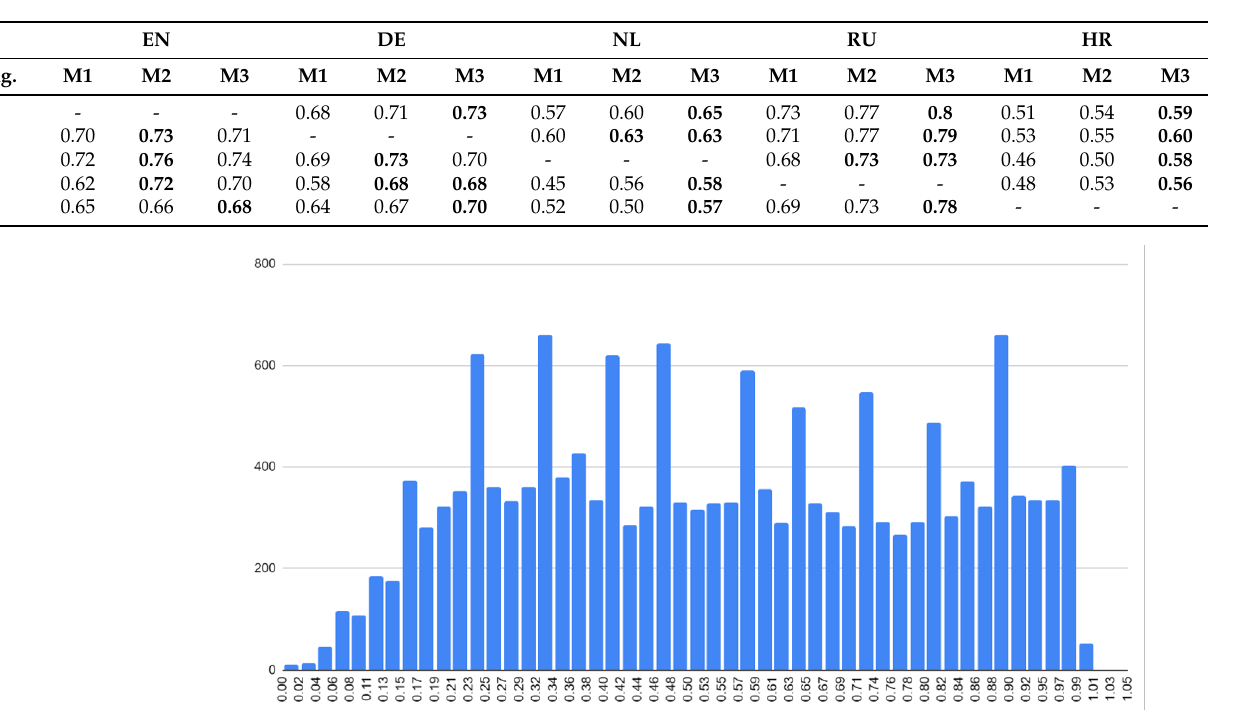
Table 3. Spearman’s correlation coefficient for complete dictionaries. Notation: ‘M1’ stands for the distilled multilingual BERT, ‘M2’ stands for the multilingual BERT, ‘M3’ stands for the MS-MiniLM (bold face corresponds to the best model for a language).